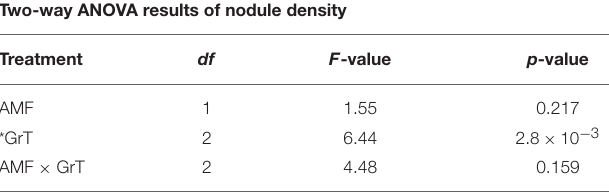
TABLE 6 | Two-way ANOVA results of nodule density in rhizobia and AMF + rhizobia treated plants under gravitational treatments (GrT). Two-way ANOVA results of nodule